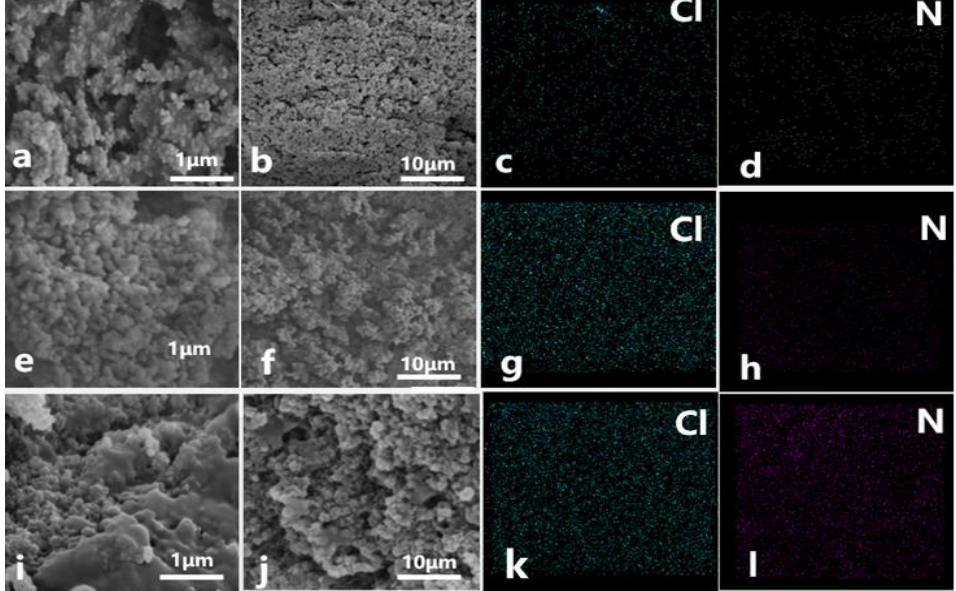
Figure 3. ( a ) TGA curves of HCP, HCP-CH 2 -Cl-1, and [HCP-CH 2 -Im][Cl]-1, ( b ) 13 C CP/MAS NMR spectrum of [HCP-CH 2 -Im][Cl]-1, ( c ) survey scan, and ( d ) N 1 s XPS spectra of [HCP-CH 2 -Im][Cl]- 1.